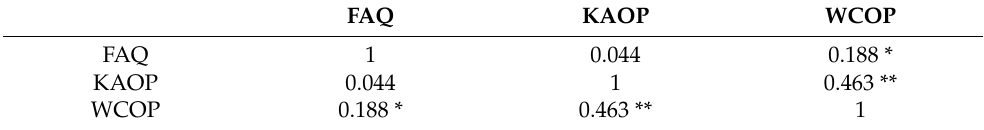
Table 4. Correlation coefficient between knowledge, attitude, and care willingness (N = 139). FAQ KAOP WCOP